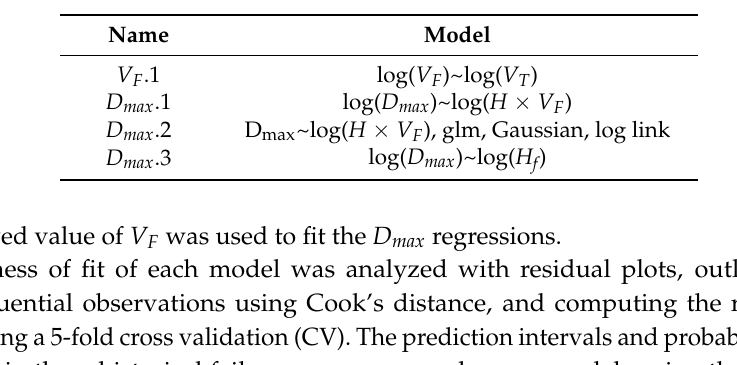
Table 2. Fitted models.